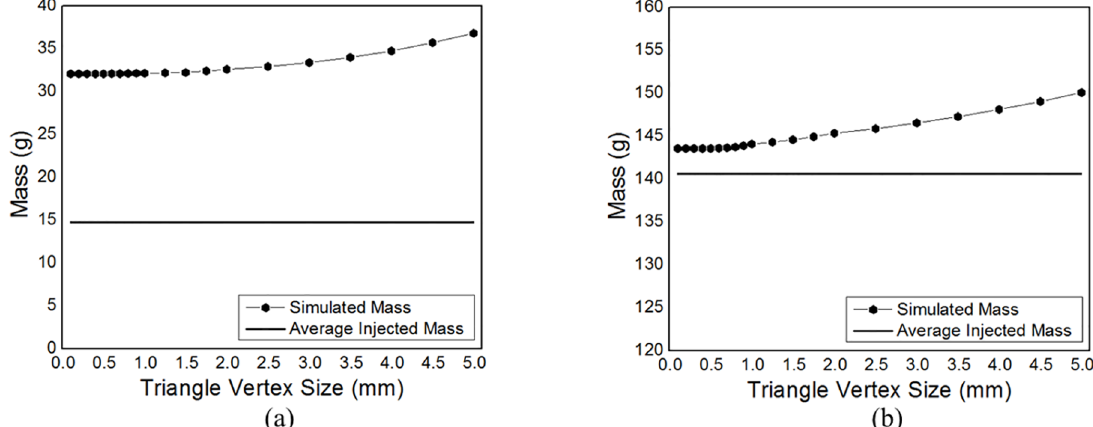
Figure 8. Influence of the mesh element size on the simulation data obtained considering the mold with no venting system: a) condition of lowest injection efficiency; b) condition of highest injection